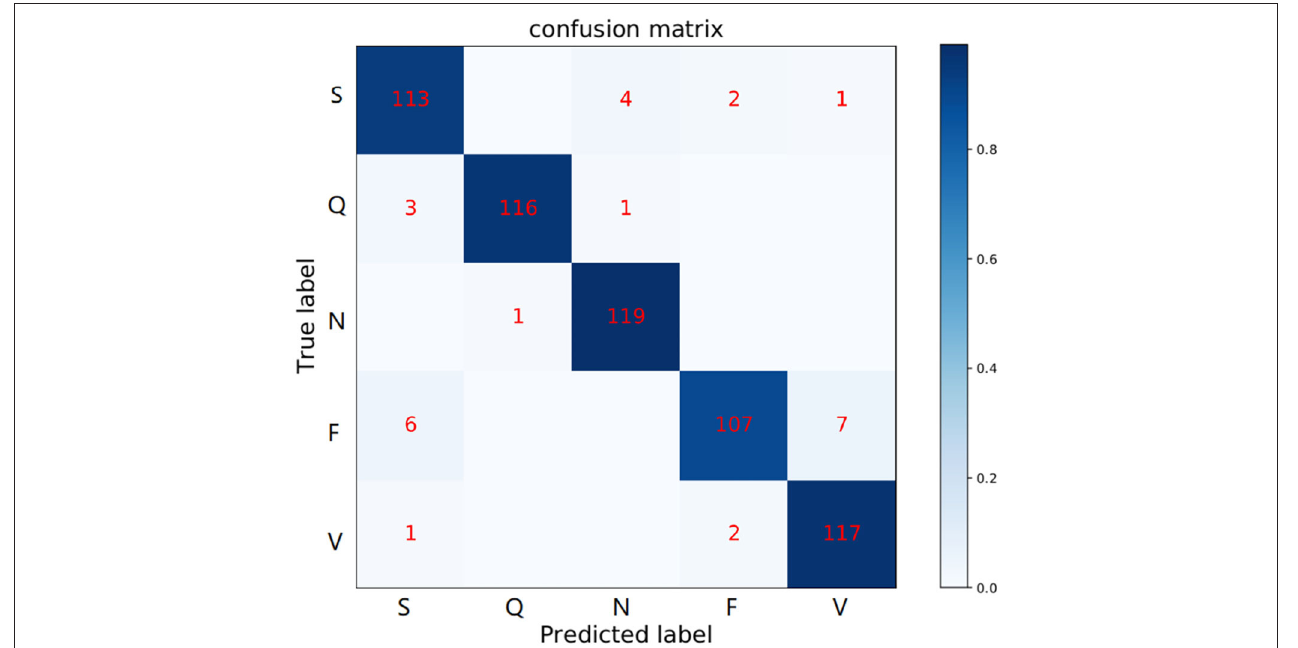
FIGURE 8 | Confusion matrix of MAE model in the MIT-BIH Arrhythmia database. The row labels represent the true class records in each row and the column labels represent the class records predicted by our method. Numbers in each grid show the number of records classified as column labels when its true class is indicated by row label.